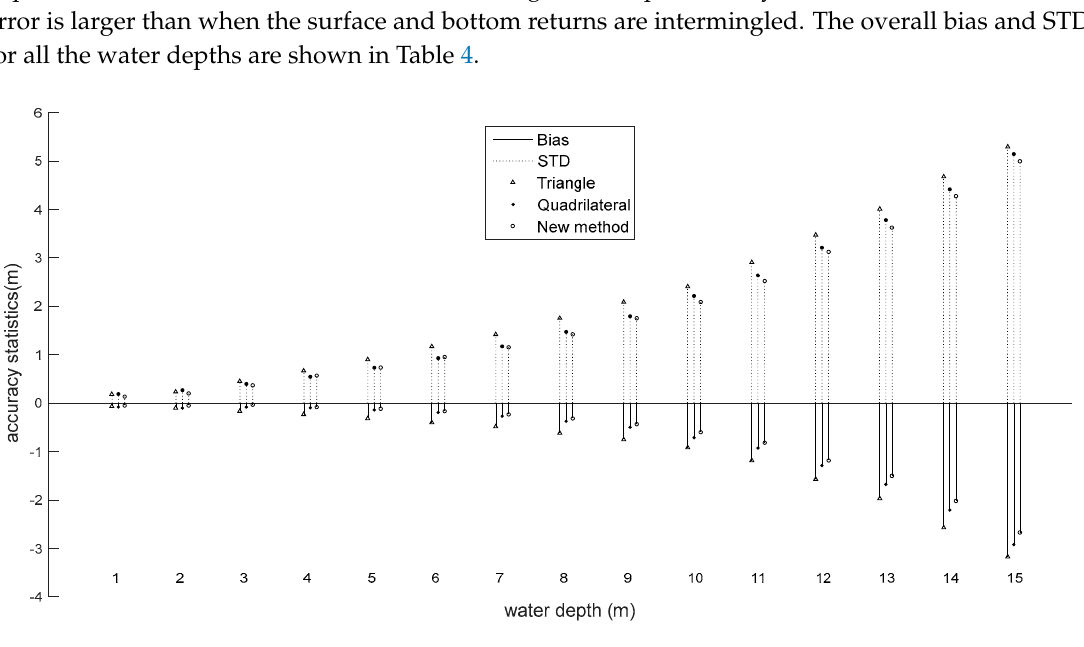
Figure 3. Bias and STD of the bathymetry estimates versus water depth.